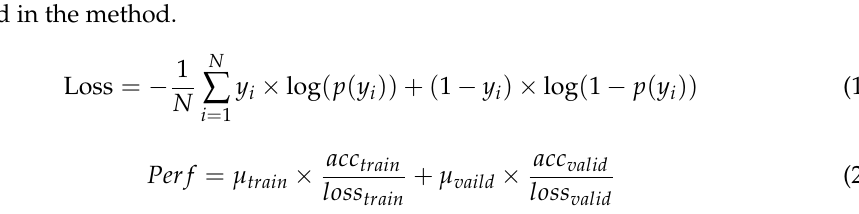
Table 2. Performance evaluation of deep transfer neural networks. DNN